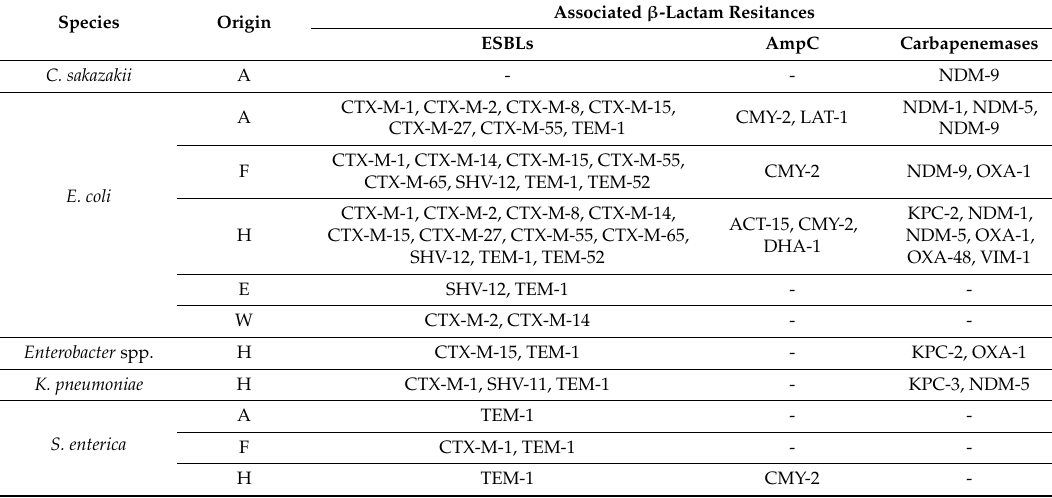
Table 8. Associated β -lactam resitances in colistin-resistant mcr-1 carrying